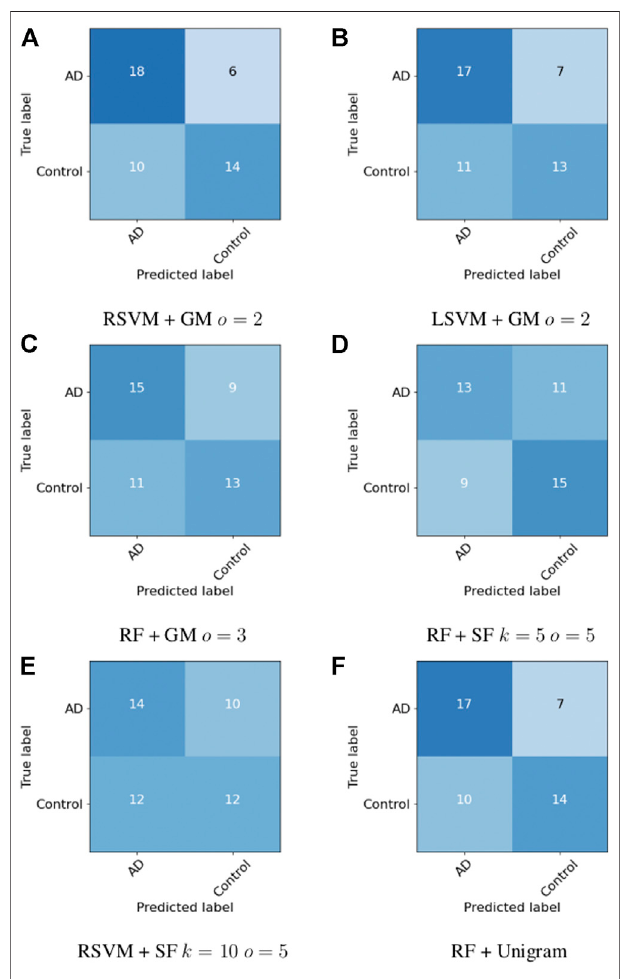
FIGURE 3 | Confusion matrices for the test